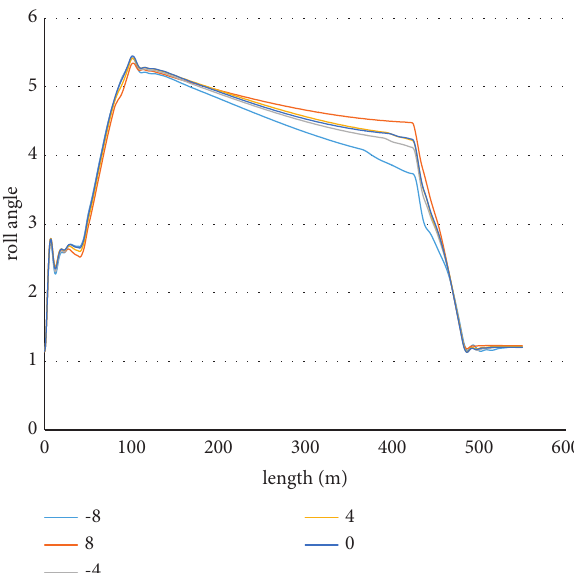
Figure 16: Comparison of overturning angle along the path on different slopes.